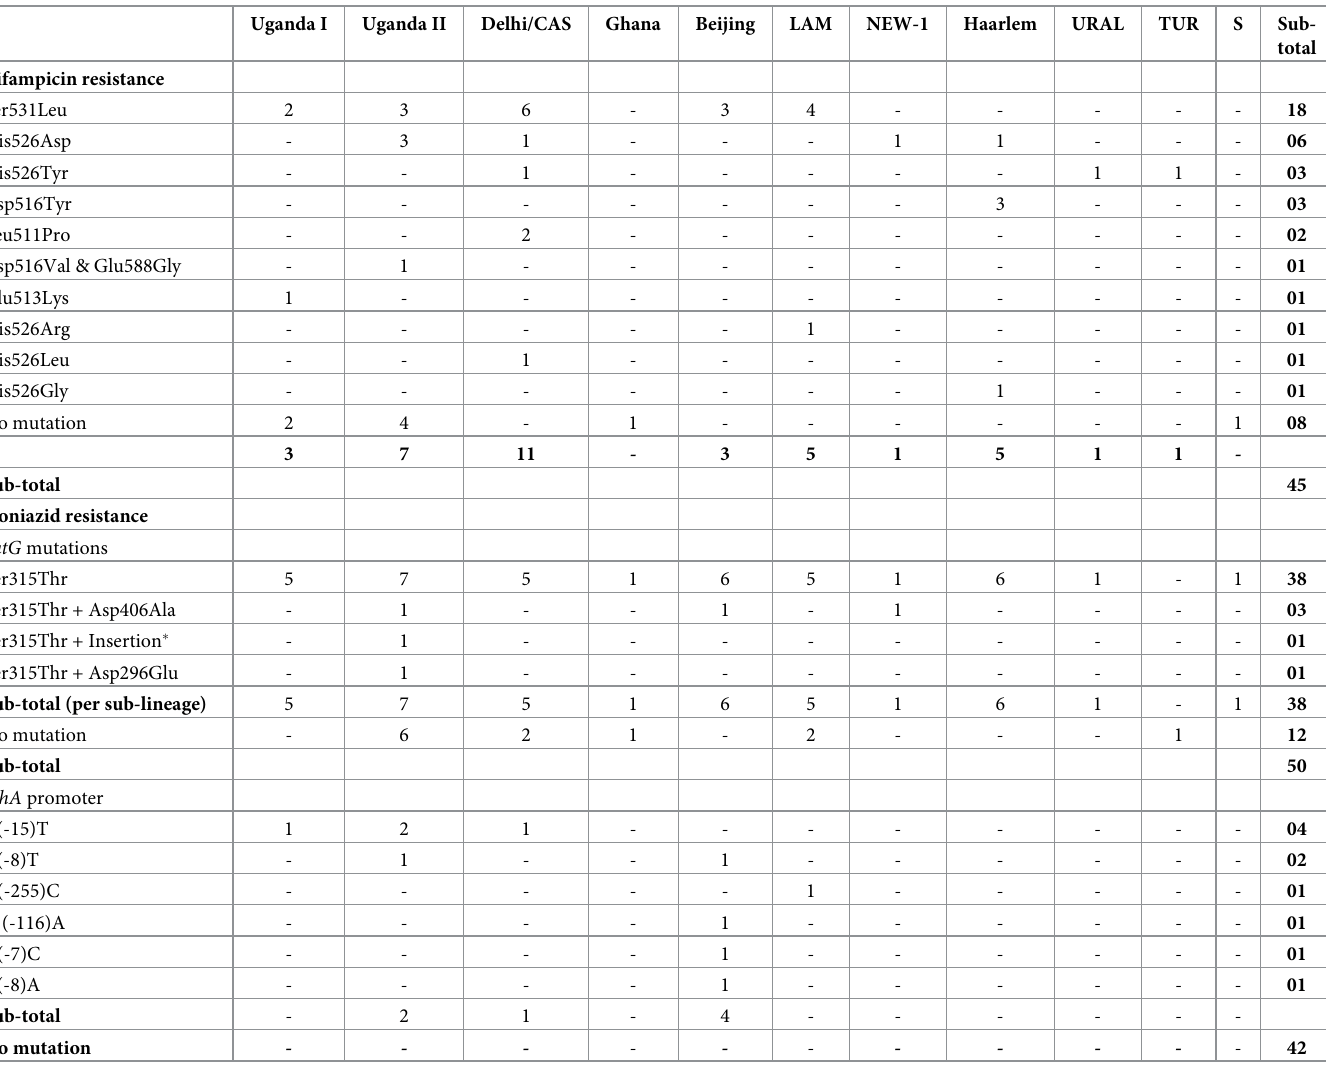
Table 2. Frequency of rifampicin/isoniazid-resistance conferring mutations in the circulating M . tuberculosis genotypes/sub-lineages in Uganda